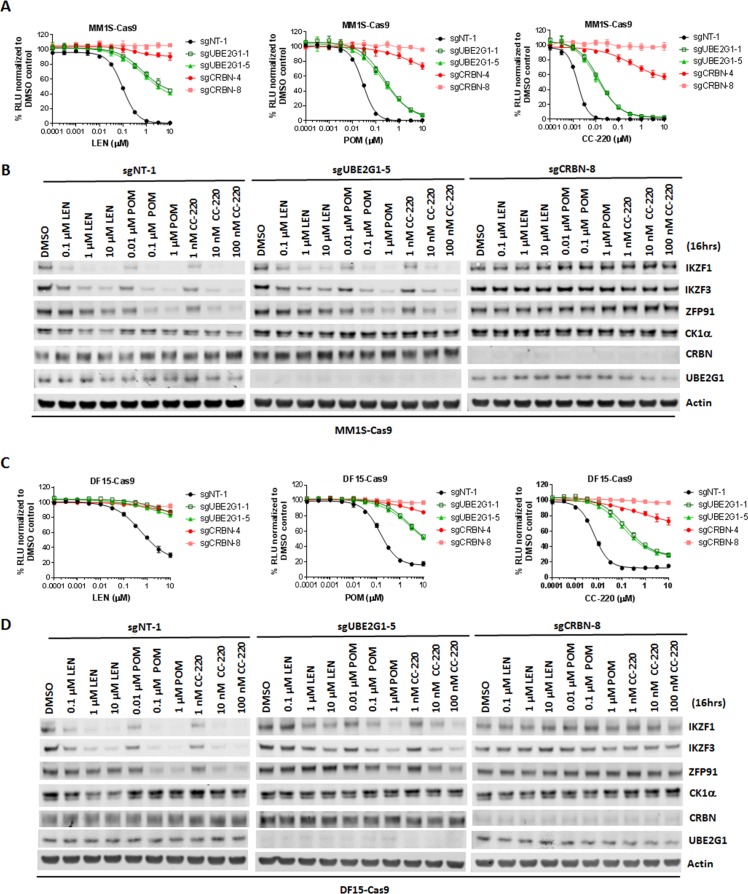
UBE2G1 knockout diminished the responses to lenalidomide, pomalidomide and CC-220 in myeloma cell lines DF15 and MM1S.(A–D) Cell proliferation (A and C) and immunoblot analysis (B and D) of MM1S-Cas9 (A and B) and DF15-Cas9 (C and D) cells infected with lentiviral vectors expressing non-targeting, UBE2G1-specific or CRBN-specific sgRNAs. Cells were treated DMSO vehicle control, LEN, POM or CC-220 at the indicated concentrations for 5 days (A and C) or 16 hr (B and D). In (A) and (C), cell proliferation was determined by CTG, and data are presented as mean ± SD, n = 3 technical replicates. All results shown in this figure are representative of three independent experiments.10.7554/eLife.40958.027Figure 7—figure supplement 1—source data 1.CTG luminescence signal shown in Figure 7—figure supplement 1A,C.